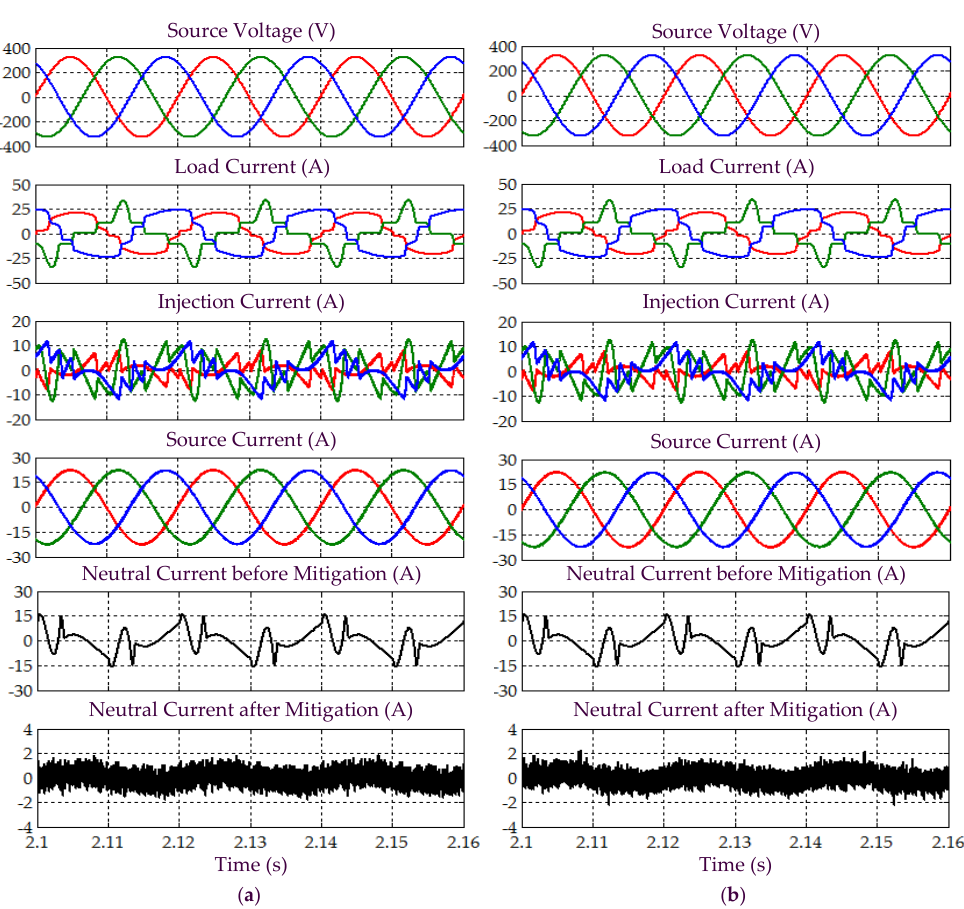
Figure 8. Simulation results obtained under Scenario A for Load 2, which include three-phase source voltage v Sabc , load current i Labc , injection current i injabc , source current i Sabc , and neutral current before and after mitigation, demonstrated by SAPF while applying the ( a ) proposed STF- dq 0 and ( b ) standard dq 0